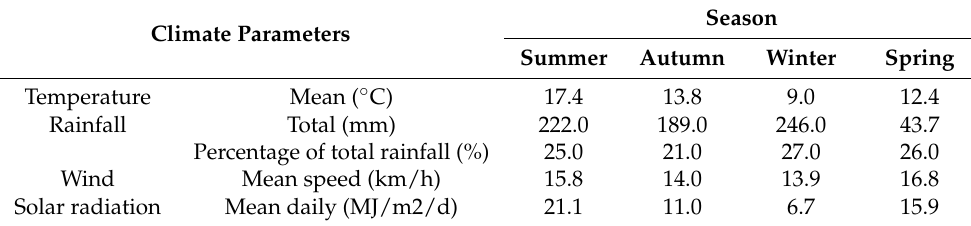
Table 1. Summarized long-term climatic conditions for Palmerston North district (Source